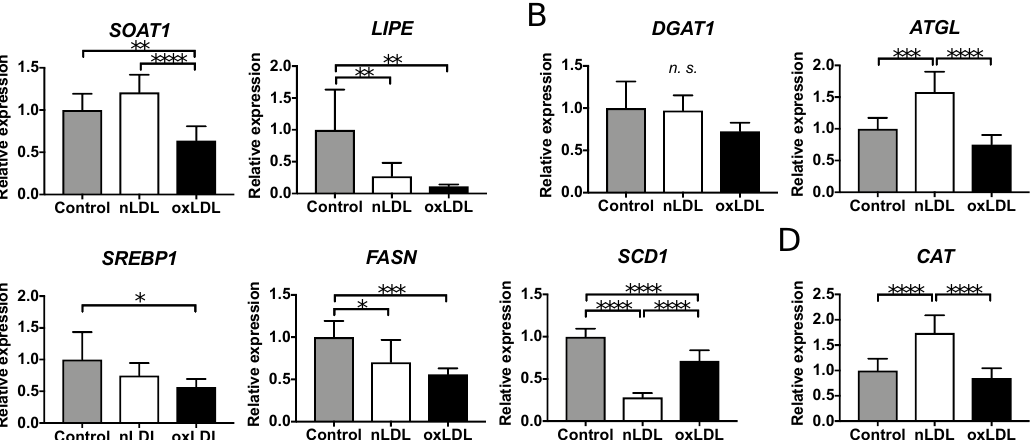
Figure 6. Expression of genes related to lipid metabolism in the LDL-supplemented C3A cells detected using real-time PCR. ( A ) Biosynthesis and degradation of CE: SOAT1 and LIPE ; ( B ) Biosynthesis and degradation of TG: DGAT1 and ATGL ; ( C ) Biosynthesis marker of fatty acids: SREBP1 , FASN , and SCD1 ; ( D ) Antioxidants: CAT . Results are shown as the relative expression levels compared to the control (PBS), which was set to 1.0. n = 6–8. One-way ANOVA with Tukey’s multiple comparisons test, * p < 0.05, ** p < 0.01, *** p < 0.001, **** p < 0.0001, n.s. not